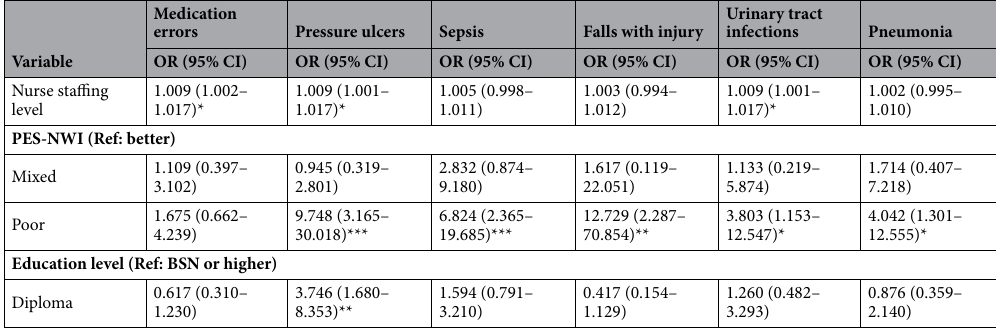
Table 3. Logistic regression model for adverse events (N = 216). This analysis controls for nursing home characteristics (location, ownership & number of beds) and nurses’ characteristics (age and work experience). The PES-NWI (Practice Environment Scale of the Nursing Working Index) for a mixed work environment showed no statistically significant relationship with all independent variables. The number of medication errors and pressure ulcers, and sepsis frequency, were analyzed as binaries, with “Never” indicating (0) and “A few times a year or less ~ everyday” indicating (1). However, because the “Never” frequency of falls with injury, urinary tract infections and pneumonia was too small, the analysis was conducted as binaries, with “Never and a few times a year or less” indicating (0) and “Once a month or less ~ everyday” indicating (1). OR Odds ratio, 95% CI 95% confidence interval, Ref Reference, BSN Bachelor of Science in Nursing. * p < 0.05; ** p < 0.01; *** p <